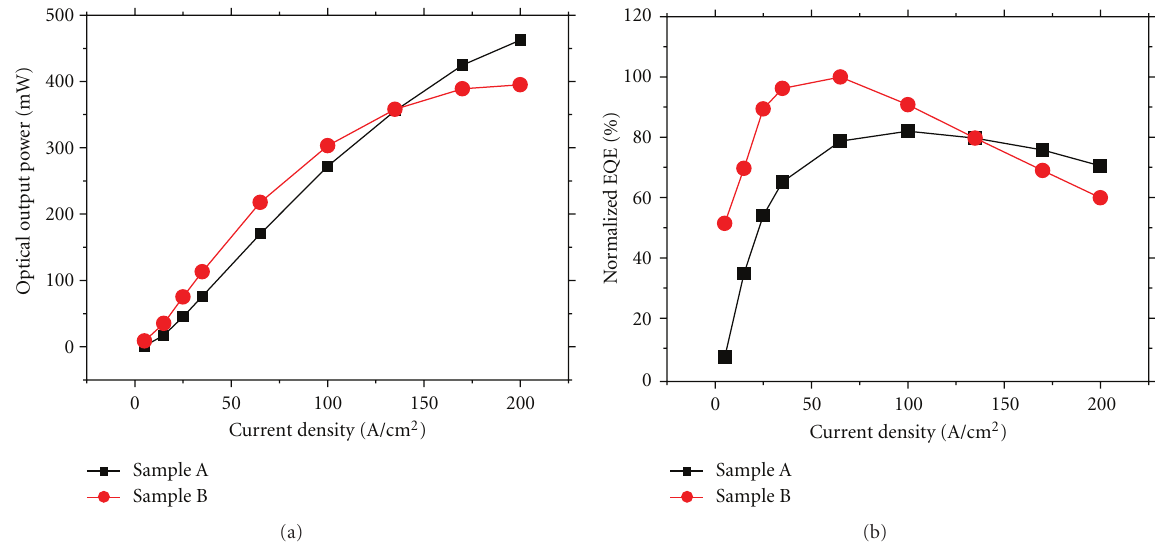
Figure 2: (a) Light output power and (b) normalized EQE of LED samples A and B, plotted with respect to the forward current